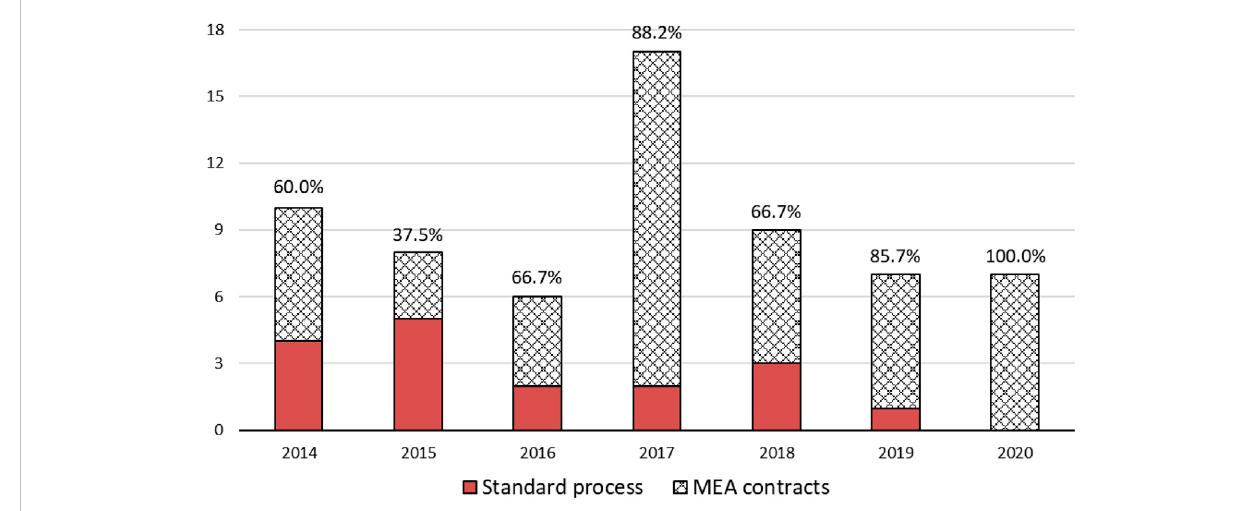
FIGURE 4 Number of listed medicines for cancers or rare disease by year (2014 – 2020).